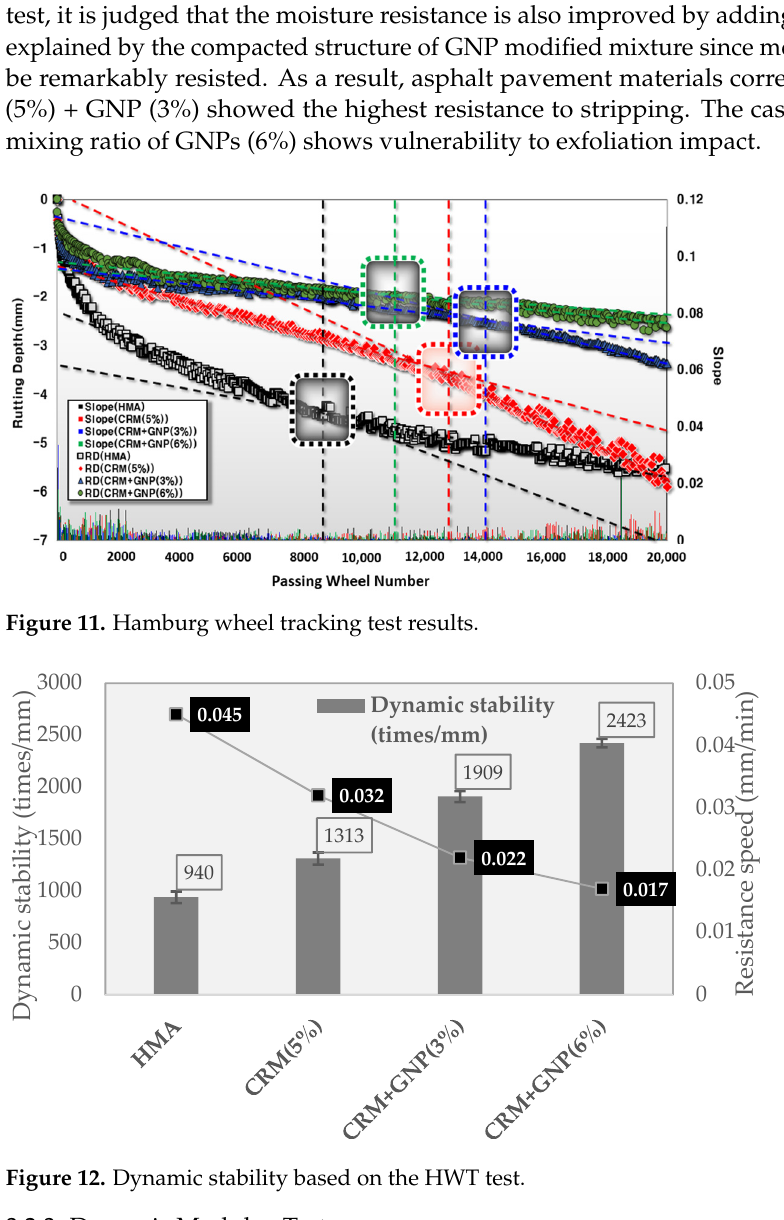
13 of 23 Figure 10. Marshall stability test results.